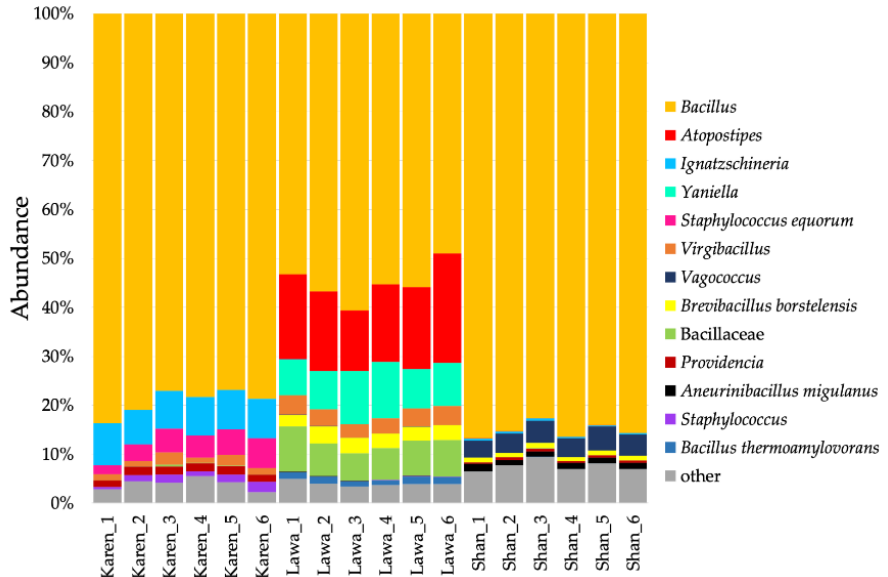
Figure 3. Bacterial proportions in fermented soybean (FSB) products from three ethnic groups: Karen, Lawa, and Shan. The major bacterial taxon found in the FSBs of all ethnic groups was Bacillus . Other minor taxa found included Ignatzschineria , Staphylococcus , and Virgibacillus (in the Karen FSB); Atopostipes , Yaniella , Bacillaceae , Virgibacillus , and Brevibacillus (in the Lawa FSB); and Vagococcus , Proteus , and Brevibacillus (in the Shan FSB).